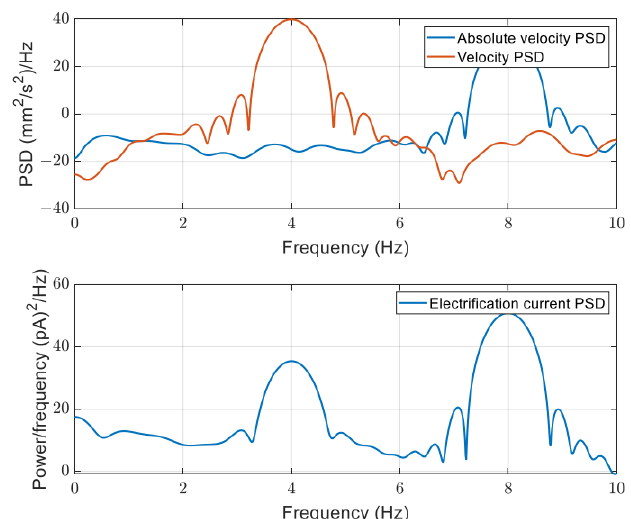
Figure 12. Power spectral densities estimated using Welch’s method of velocity and electrification current signals. The shuttle frequency is 4